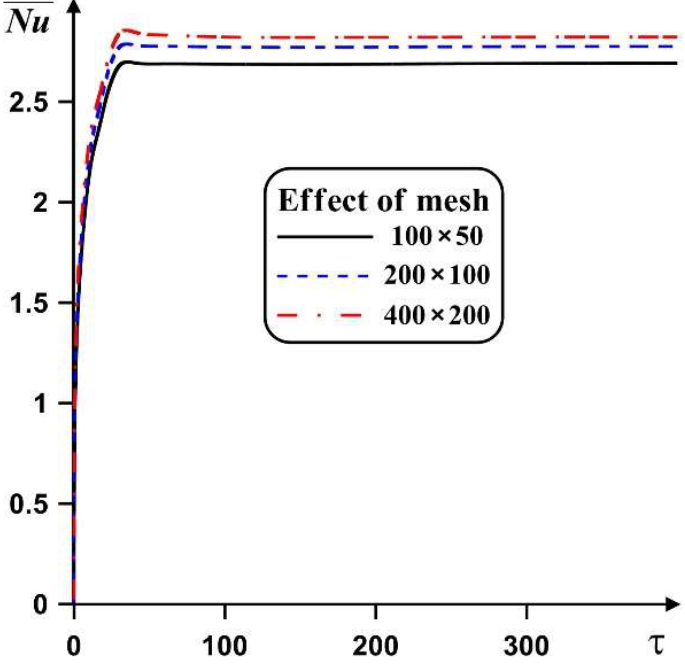
Figure 2. Time dependences of mean Nusselt number with grid parameters for Pr = 6.82 ans Ra = 10 5 .